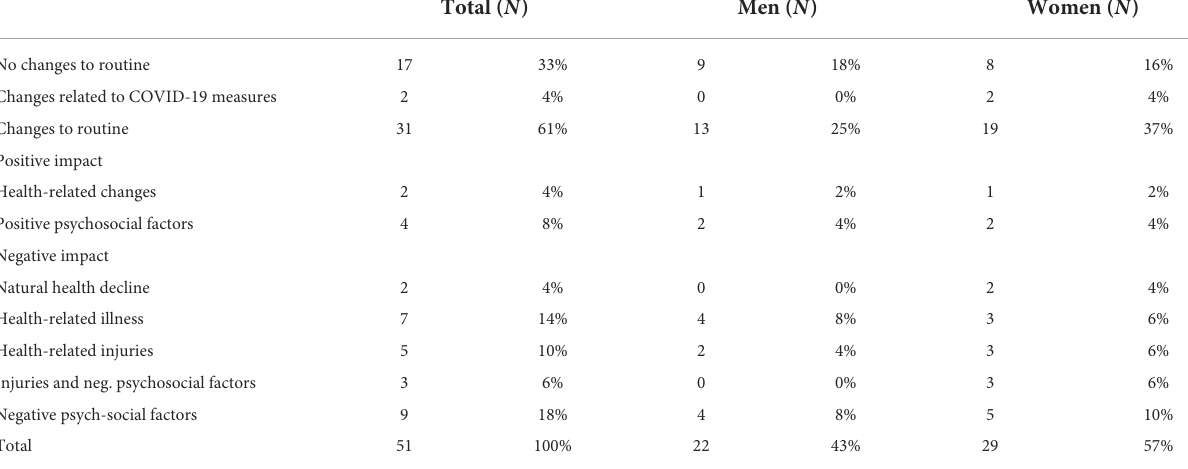
TABLE 6 Changes in daily routines over an 8-year